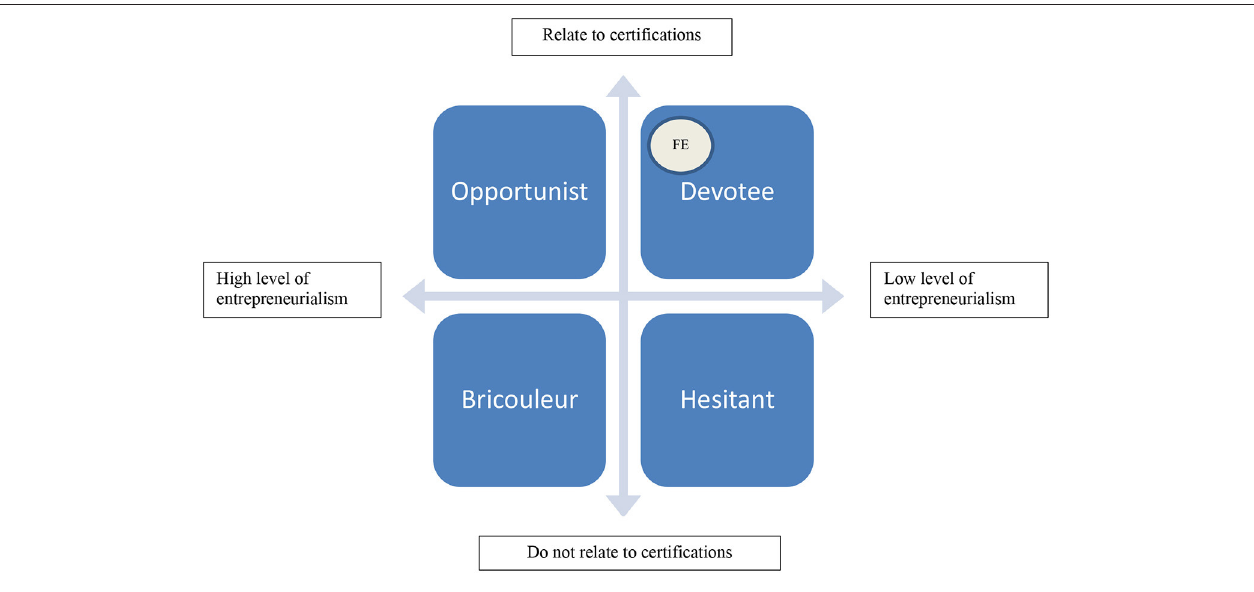
FIGURE 1 | A conceptual typology of ES work related to certification.